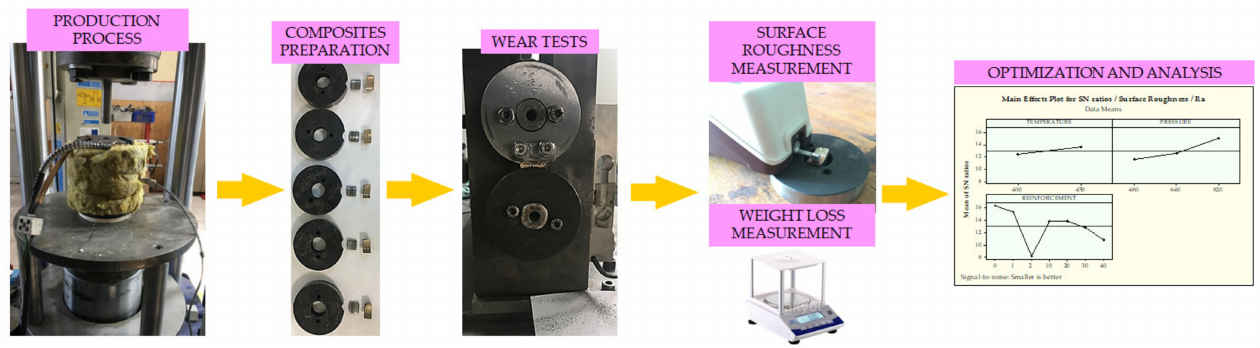
Figure 1. General outline of the paper.